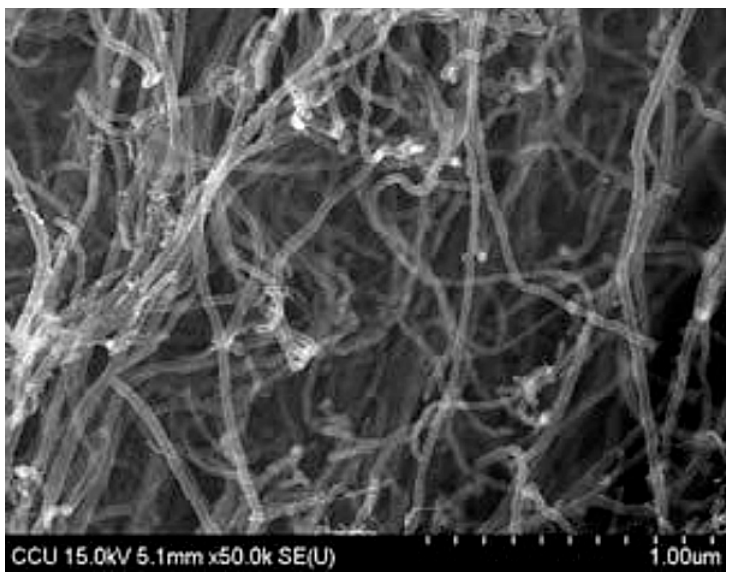
Figure 3. Scanning Electron Microscopy (SEM) image of Multi-walled Carbon Nanotube. Table 1. Properties of Multi-walled Carbon Nanotubes (MWCNTs) involved in this work.